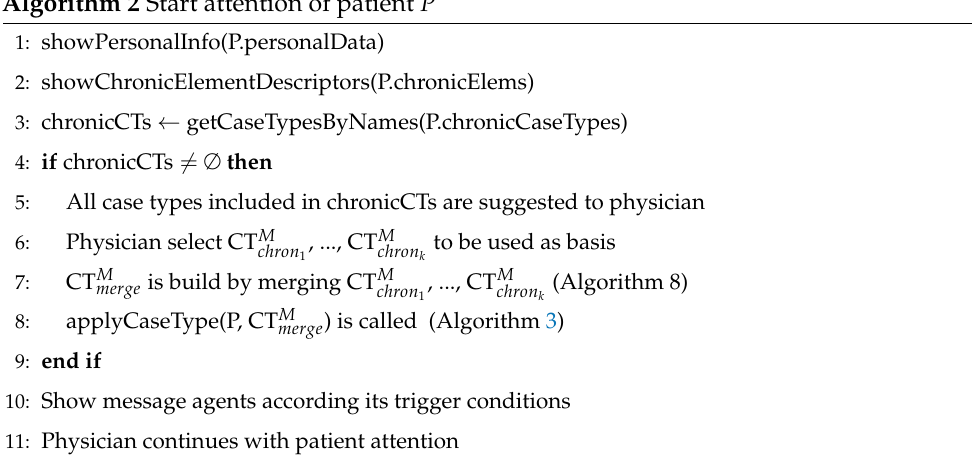
Algorithm 2 Start attention of patient